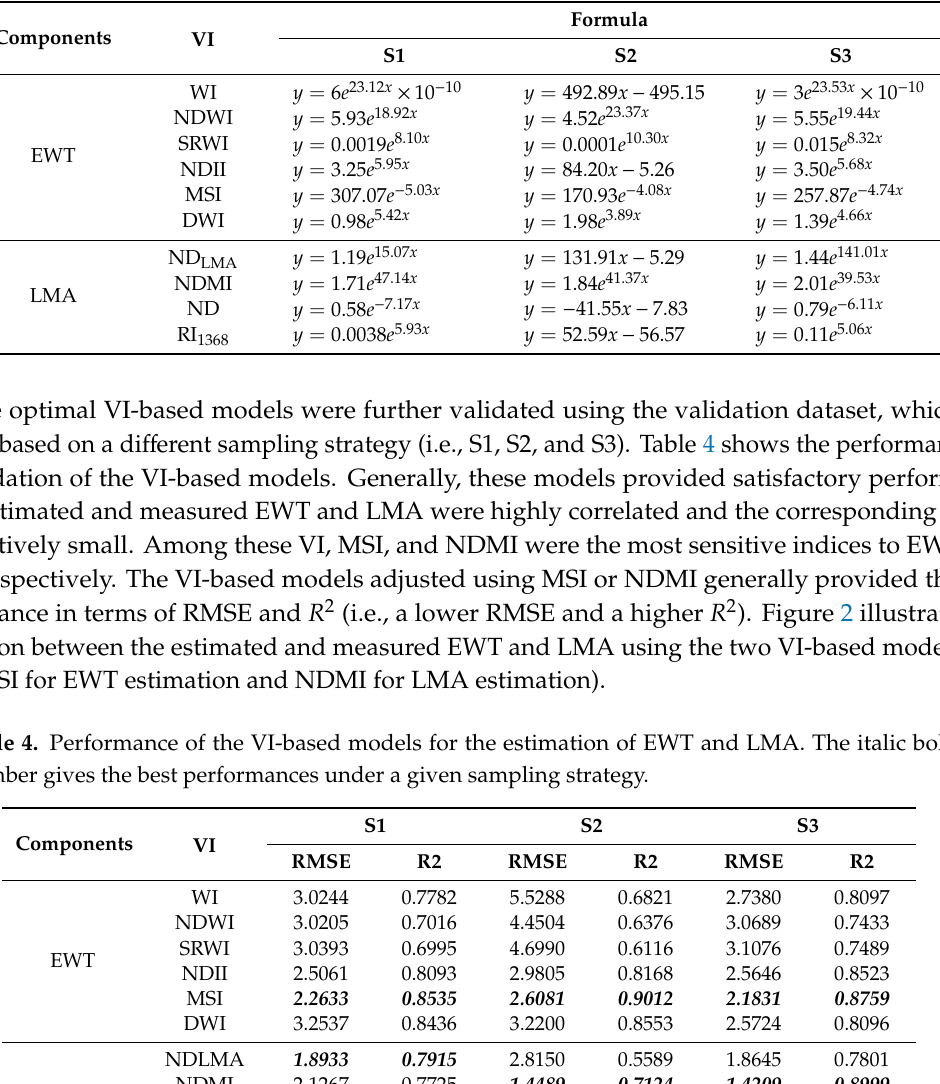
Table 3. The optimal vegetation indices (VI)-based method for the estimation of EWT and LMA. x represents the value of a given vegetation index, and y is the corresponding biochemical constituents.